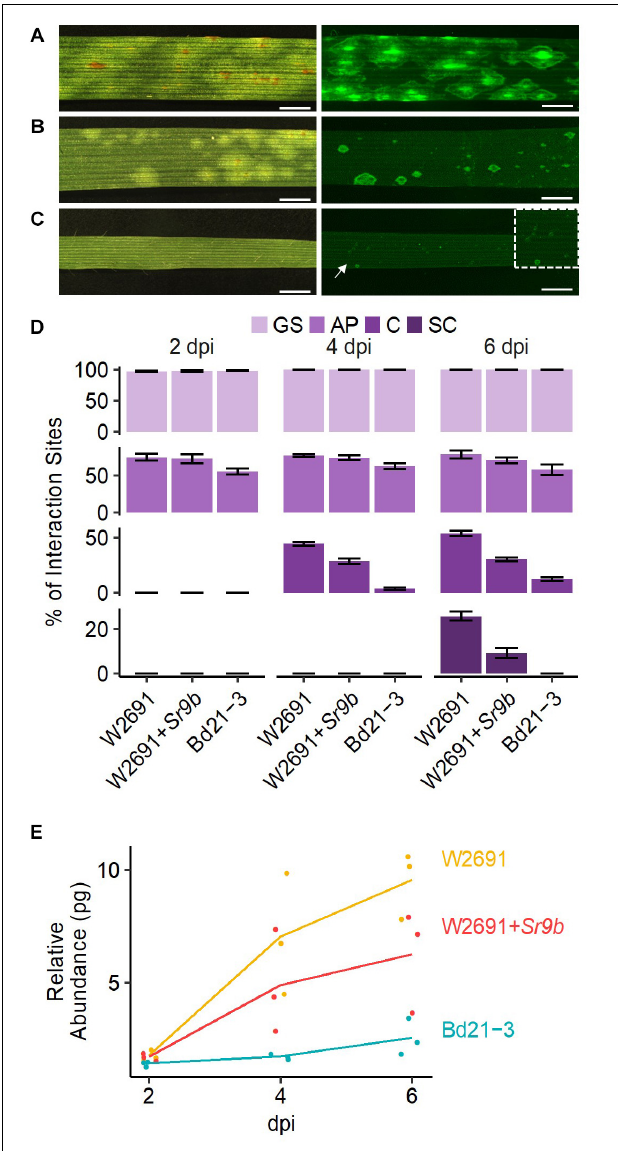
FIGURE 1 | Infection of T. aestivum and B. distachyon genotypes with P. graminis f. sp. tritici race SCCL. (A–C) Development of disease symptoms (left) and fungal colonization (right) at 6 dpi. (A) W2691 (susceptible wheat line). (B) W2691+ Sr9b (intermediate resistant wheat line). (C) B. distachyon Bd21-3 line (non-host). The white arrow and the white box indicate the area which was enlarged for better visualization of colonies. Scale bars indicate 2 mm. (D) Percentage of fungal infection sites which showed germinated urediniospores (GS), appressorium formation (AP), colony establishment (C) , and sporulating colony (SC). Error bars represent the standard error of three independent biological replicates. (E) Fungal DNA abundance in infected W2691, W2691+ Sr9b , and Bd21-3 genotypes as measured using qPCR. The points show the sample values and the lines represents the mean of the